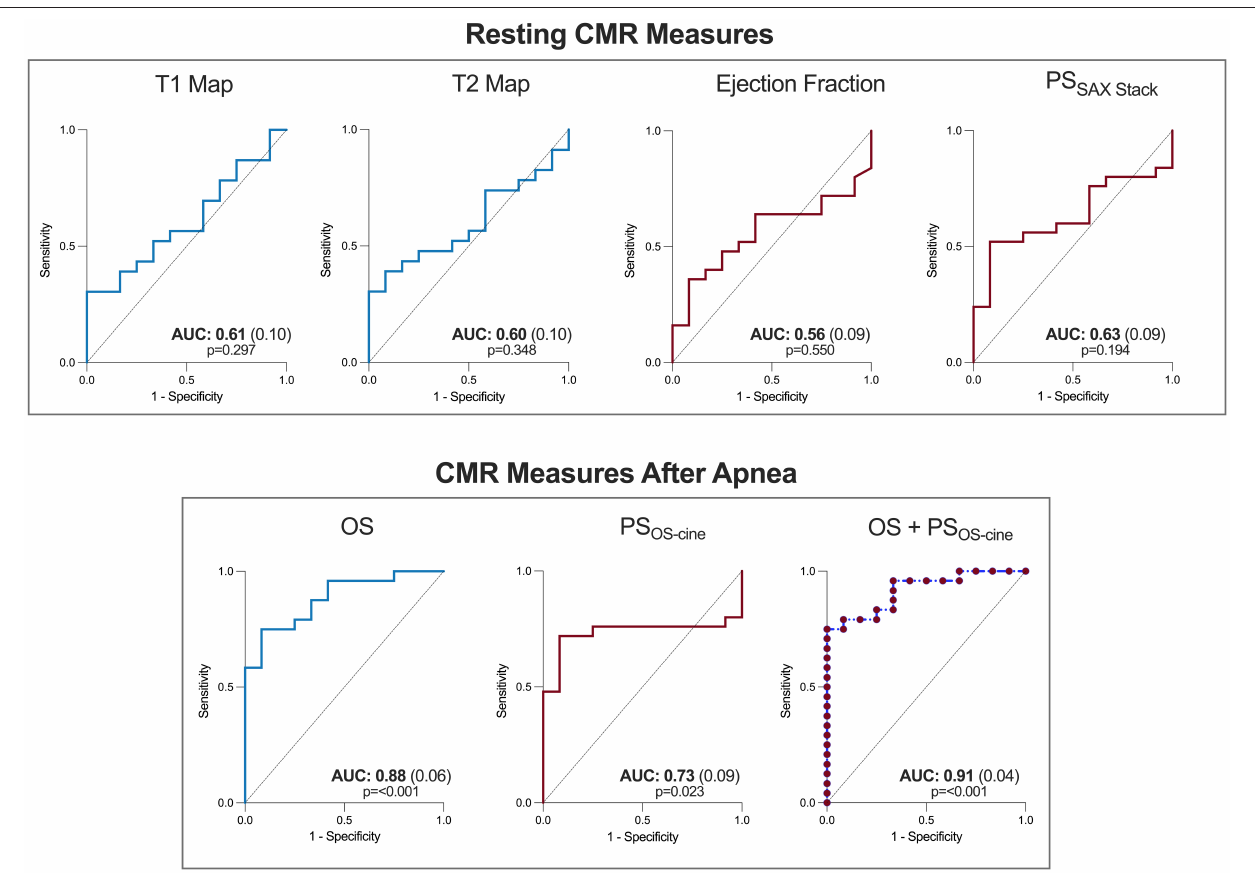
FIGURE 6 | Combined oxygenation-sensitive and feature tracking analysis improves determination of post-stenotic myocardium. Receiver operating characteristic curves are shown for the CMR parameters at resting conditions (top) for both tissue characterization sequences (blue) and functional measurements (red). The bottom row depicts the oxygenation-sensitive (OS) response after 30s of apnea, and the feature tracking peak strain (OS) measurements acquired from the same image, along with a combined predicted curve combining both tissue and functional measures. AUC, Area under the curve (standard